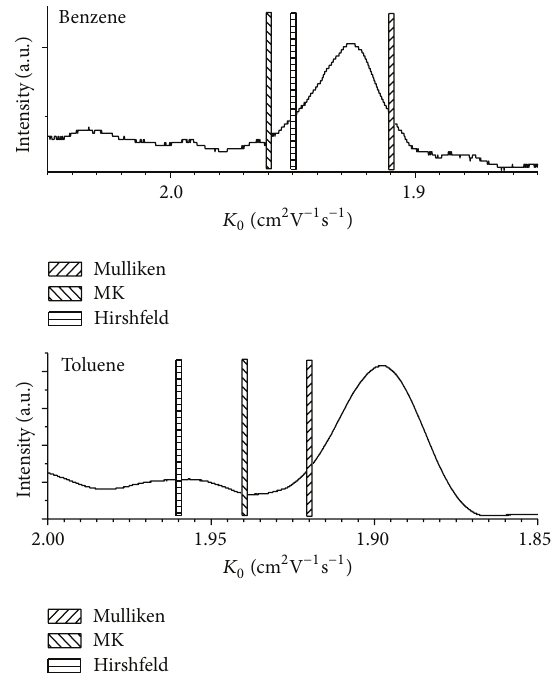
Figure 1: Measured IMS spectrum for benzene and toluene (solid line) and the calculated mobilities when the analyte is clustered with one water molecule (bars).